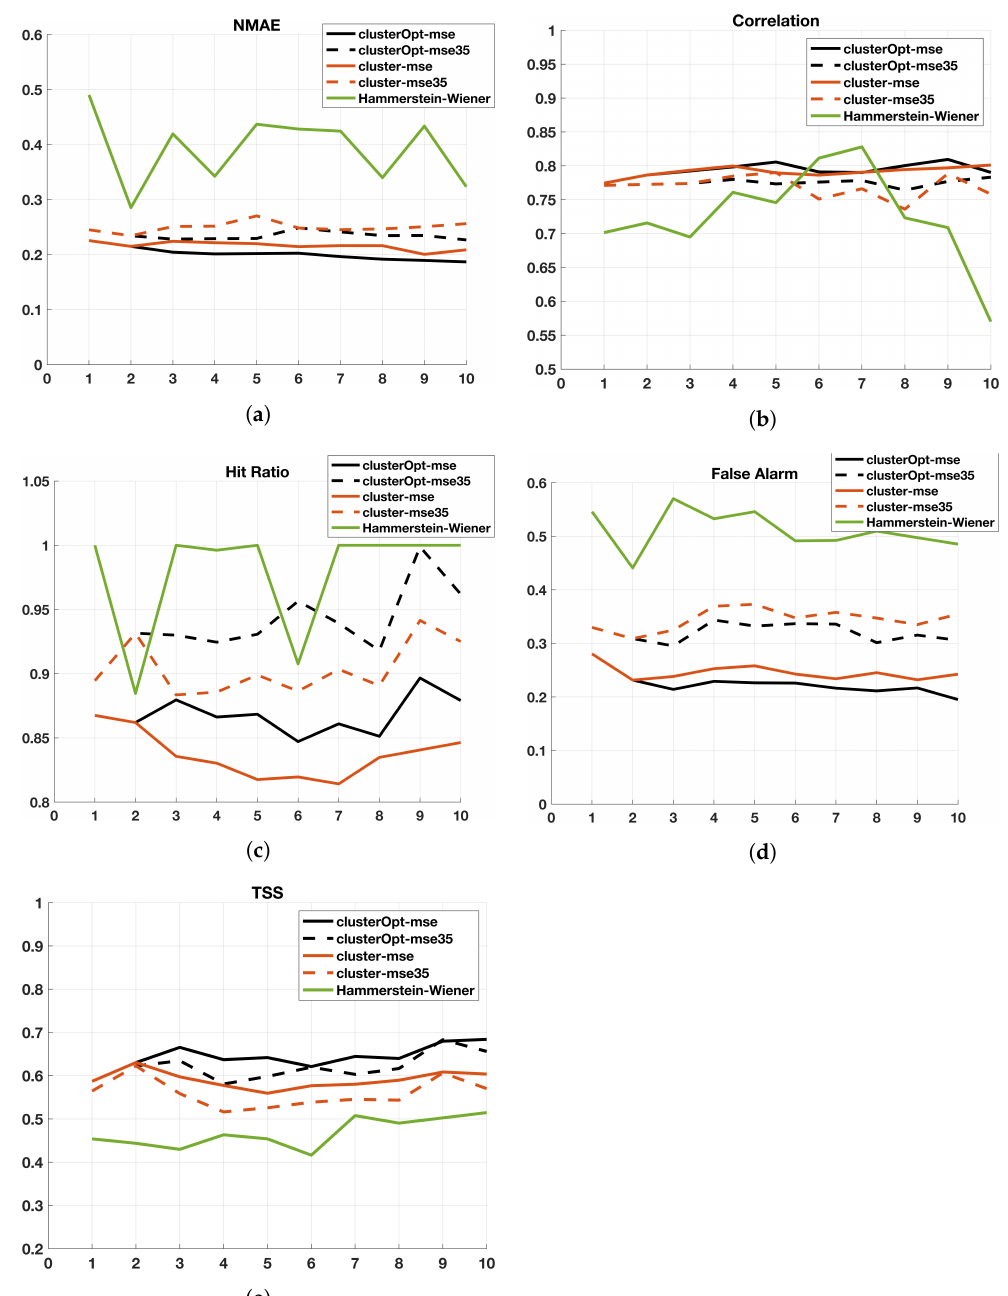
Figure 2. Index values (ordinate axis) of the 5 compared methods for K = 1 . . . 10 (abscissa axis) when n a = n l = 1. ( a ) Normalized Mean Absolute Error (NMAE); ( b ) Correlation Coefficient; ( c ) Hit Ratio; ( d ) False Alarm; ( e ) True Skill Score